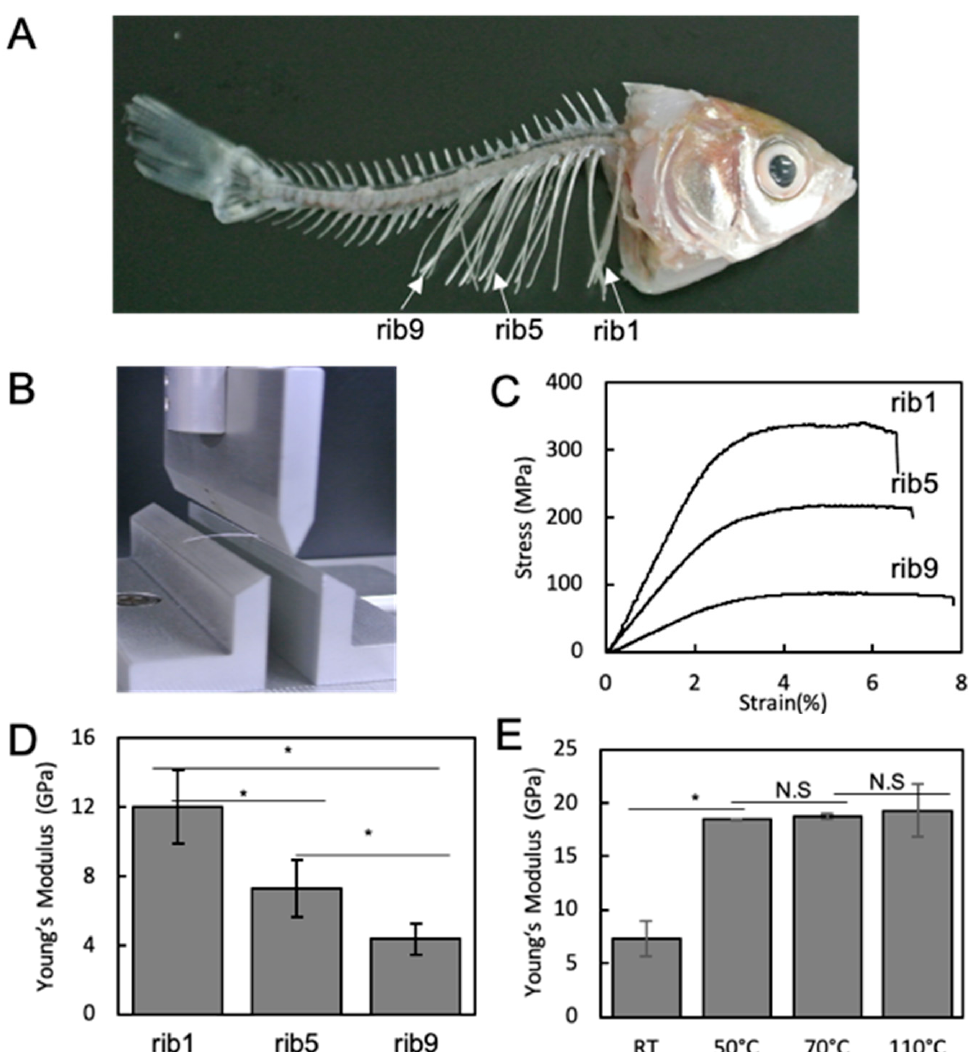
Figure 1. Mechanical property of Carassius langsdorfii rib bone. ( A ) Fish skeletal. Arrows indicate ribs 1, 5, and 9. ( B ) Three-point bending jig used in this study. ( C ) Stress–strain profiles of fish rib. Rib 1 has a higher strength than rib 5 and rib 9. ( D ) Young’s modulus of fish ribs. The more distal the location of the rib, the softer it becomes. ( E ) The alteration of Young’s modulus of rib 5 by heating. * indicates a significant difference ( p < 0.05).